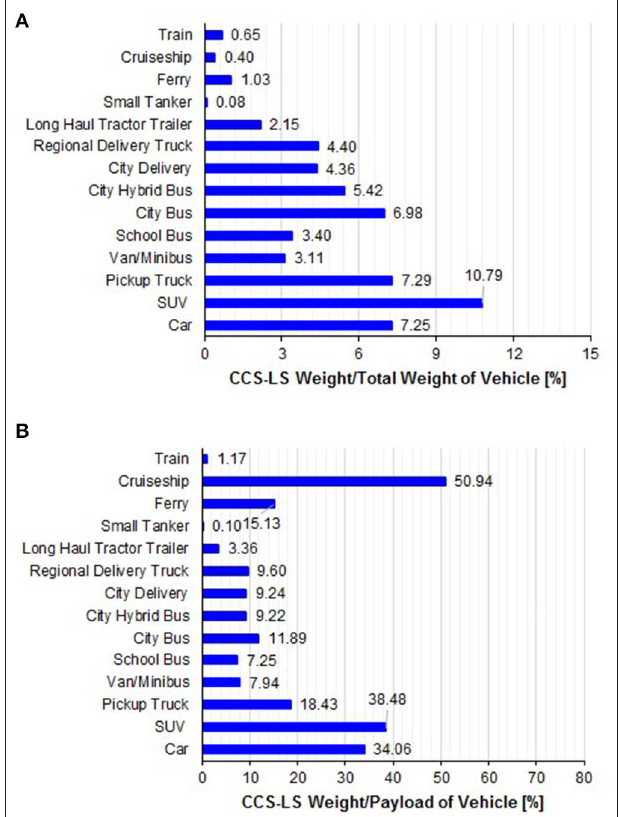
FIGURE 10 | Weight comparison between on-board storage of H 2 and different carbon based fuels with CCS-LS for conventional internal combustion engine.